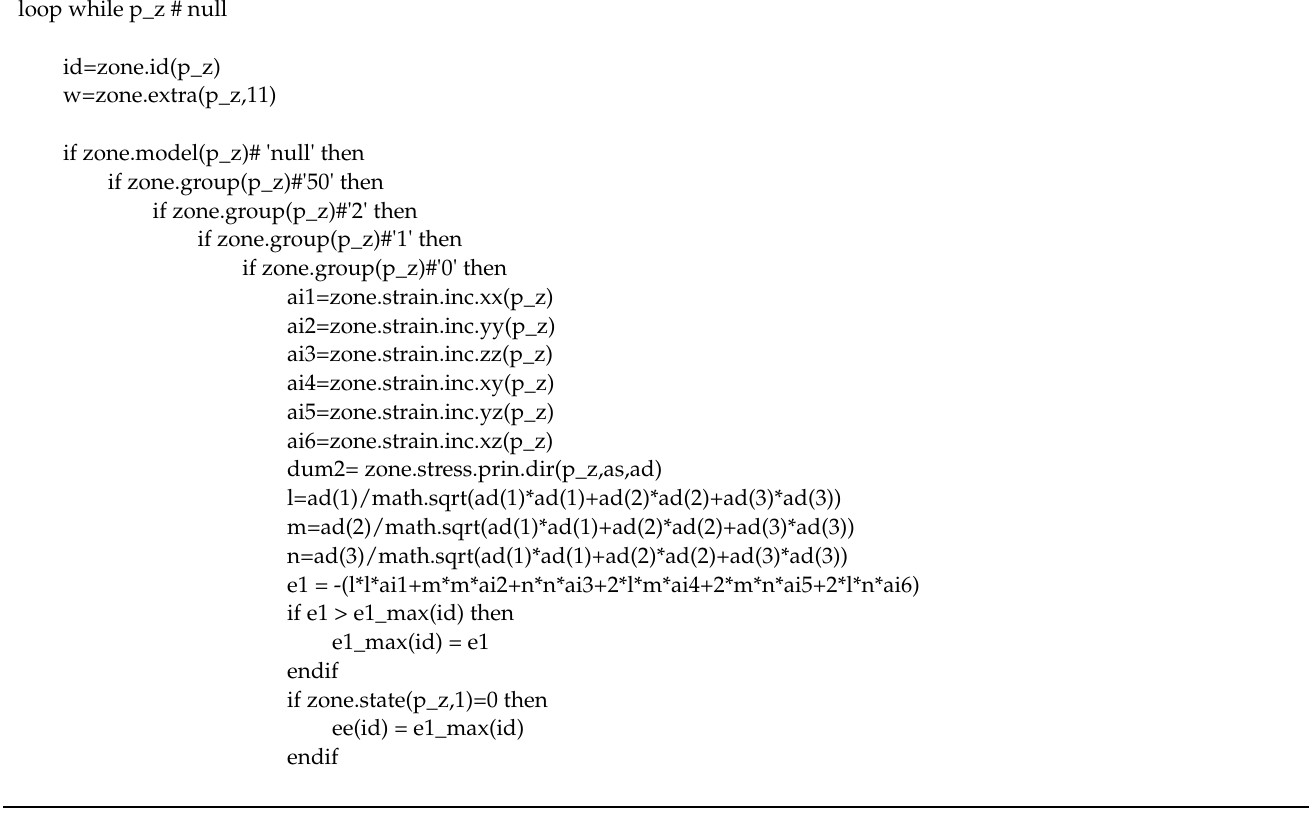
Algorithm A1. Algorithm Code of Dynamic Rock Parameter